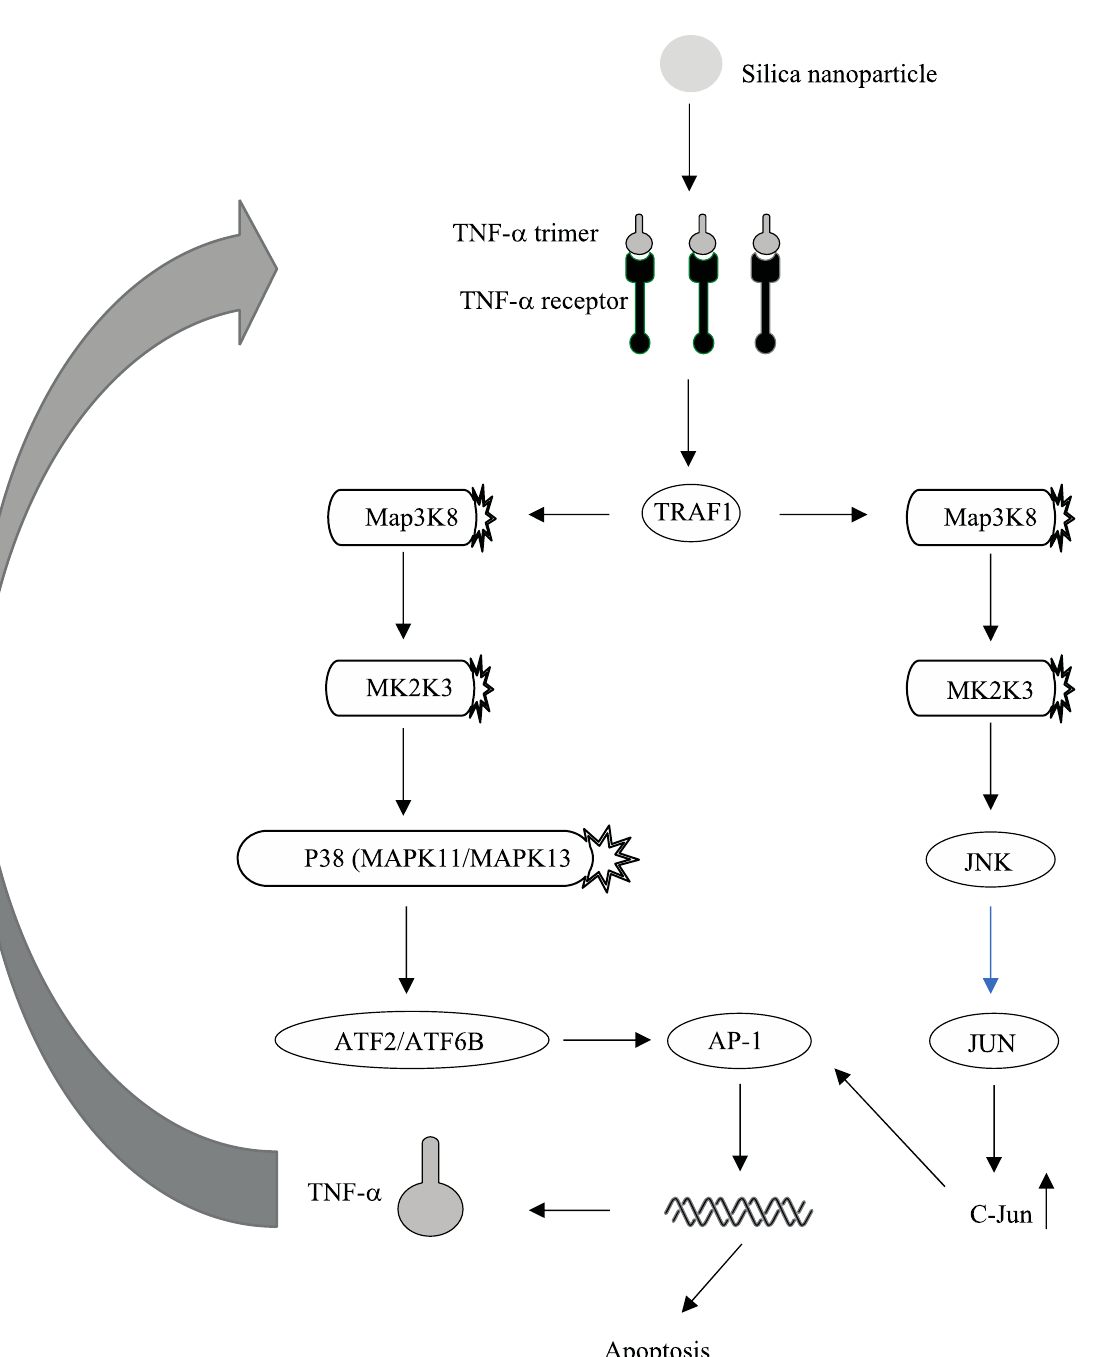
Figure 5. Proposed pathways regulated by silica nanoparticles conferring toxic effects. There are also several AP-1 related genes including PTGS2 (COX-2), LIF, and CXCL2, all of which were found to be upregulated in all three cell types. Allport et al. indicated that AP-1 is required for PTGS2 gene expression in amnion epithelial cell lines [21]. Concurrently, PTGS2 can also stimulate the release of mediators of inflammation including TNF- α , of which can promote further production of AP-1 through a positive feedback loop [22]. C-X-C motif chemokine ligand 2 (CXCL2) is a small secreted protein whose expression is regulated by the binding of AP-1 to the human CXCL2 promoter region. In addition, the expression of CXCL2 has been shown to be induced by TNF-mediated signaling in ovarian cancer cells [23]. In hepatocellular carcinoma, overexpression of CXCL2 has